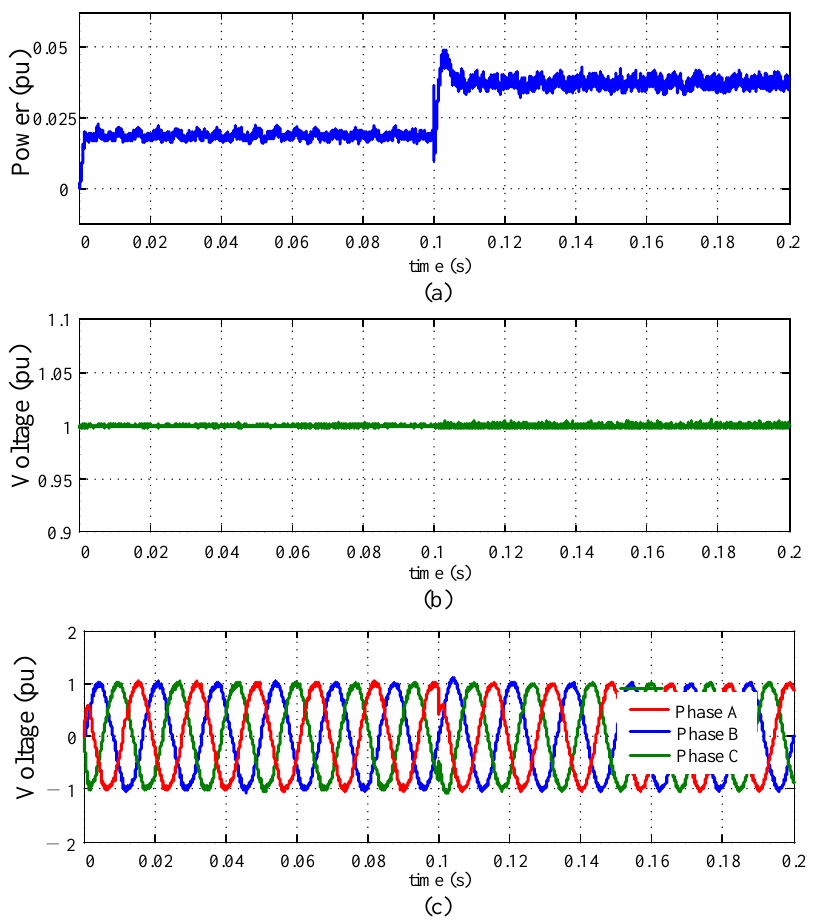
Figure 4. Simulation results of the power electronics system: ( a ) Load power; ( b ) Output voltage of the DC/DC converter; ( c ) Output voltages of the DC/AC inverter.